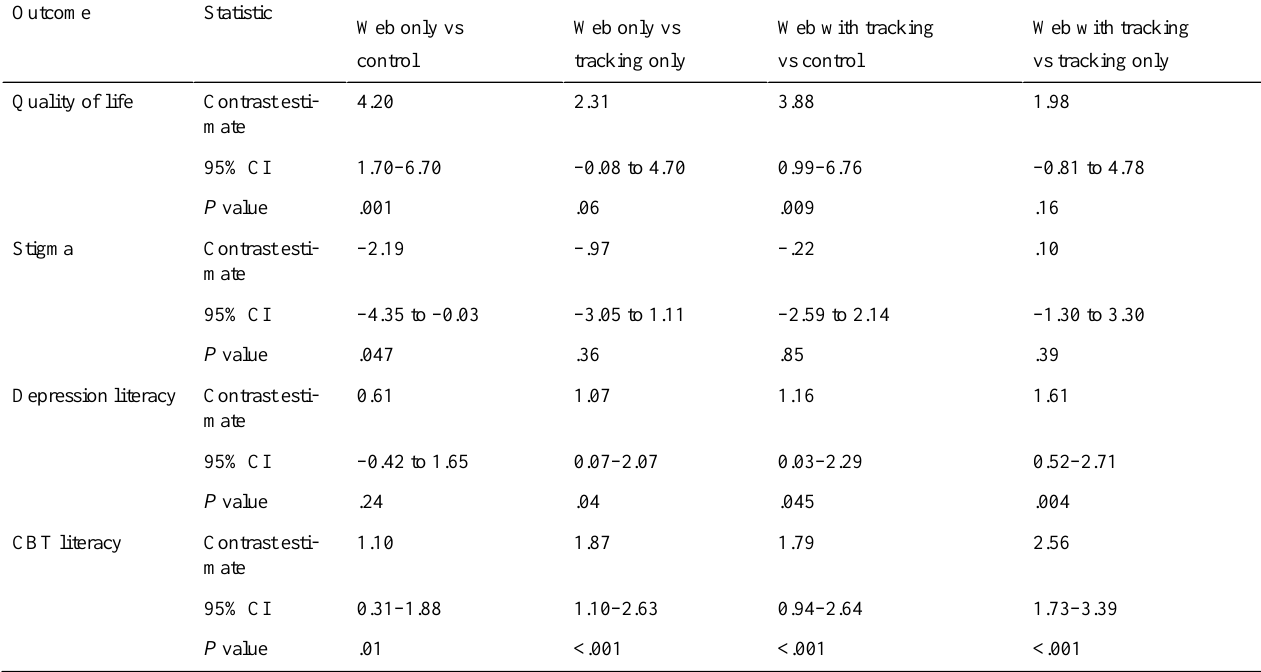
Table 2. Contrast estimates, 95% confidence intervals (CI), test of significance values, and effect size estimates for contrasts of pre- to postintervention change between intervention and control